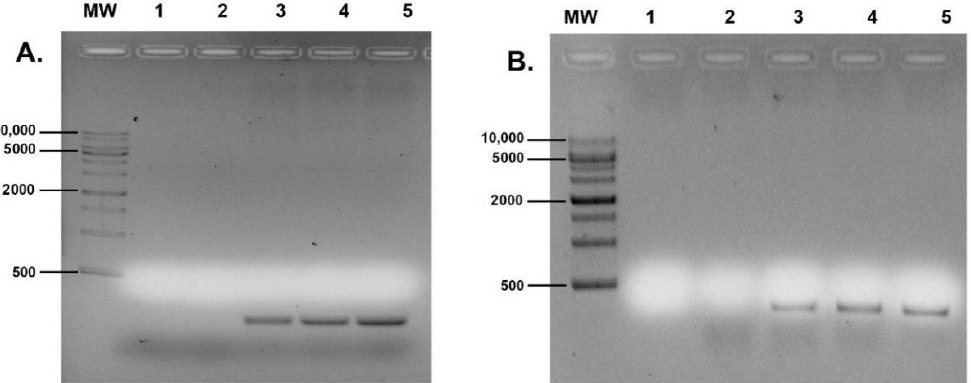
Figure 5. Analysis of RT-PCR products by agarose gel electrophoresis. Evaluation of E7 transcripts in hFIB cells ( A ) and RAW cells ( B ). Lane MW: DNA molecular weight marker (range from 500 to 10,000 bp); lane 1: control without cDNA sample; lane 2: non-transfected cells; lane 3: cells transfected by CS-TPP-pDNA [20 μg/mL]; lane 4: cells transfected by CS-TPP-pDNA [40 μg/mL]; lane 5: cells transfected by CS-TPP-pDNA [60 μg/mL]. Lanes 3, 4 and 5 present a band of 297 bp corre- sponding to the E7 transcripts.